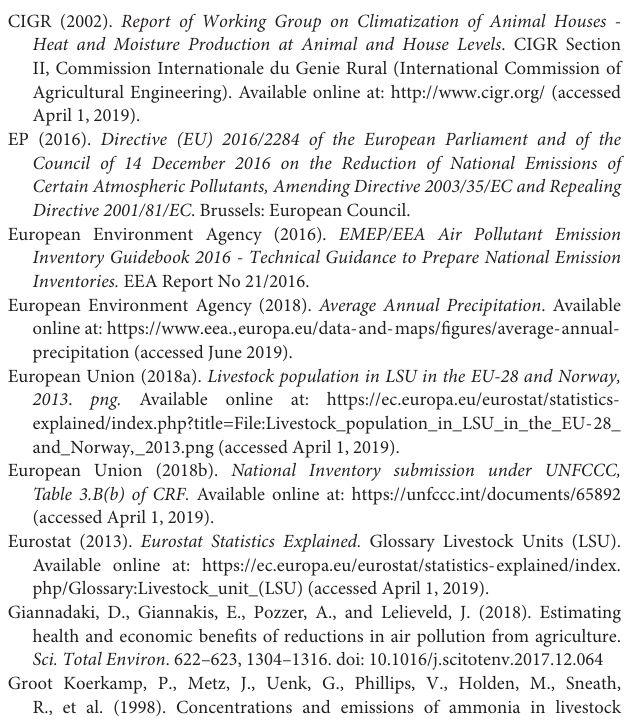
Table 3.B(b) of CRF. Available online at: https://unfccc.int/documents/65892 (accessed April 1, 2019). Eurostat (2013). Eurostat Statistics Explained. Glossary Livestock Units (LSU). Available online at: